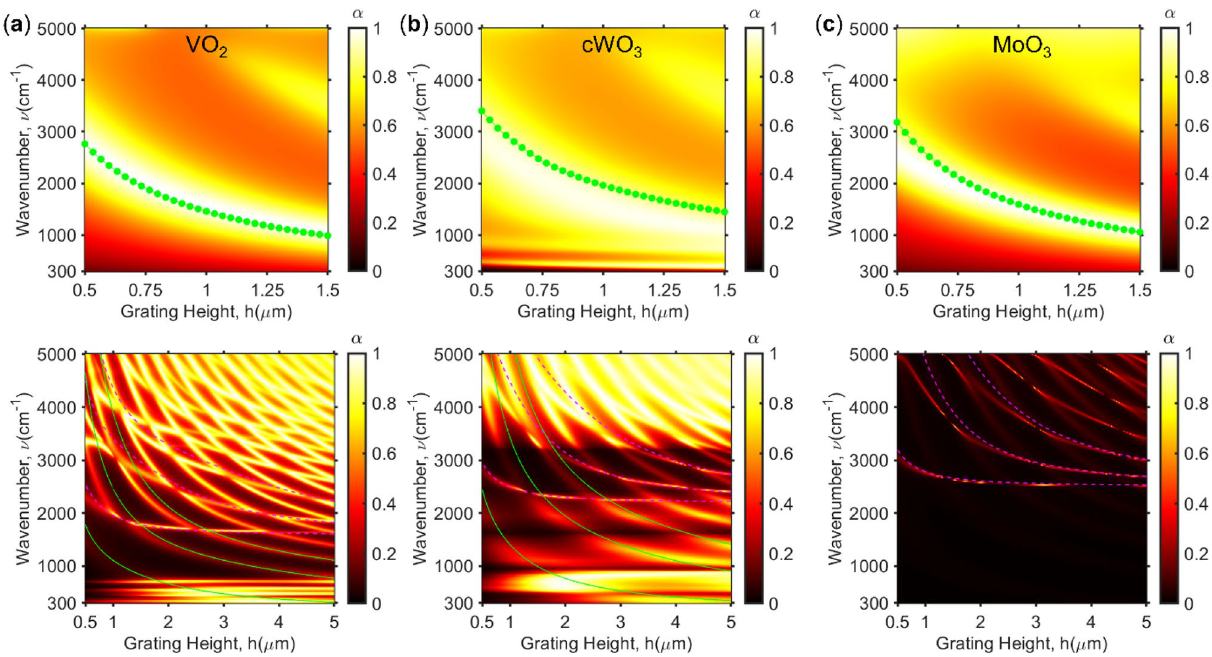
Figure 4. Absorptance contour in respect with grating height and wavenumber at metallic state (upper row) and insulating phase (lower row) for ( a ) VO 2 , ( b ) cWO 3 , and ( c ) MoO 3 .